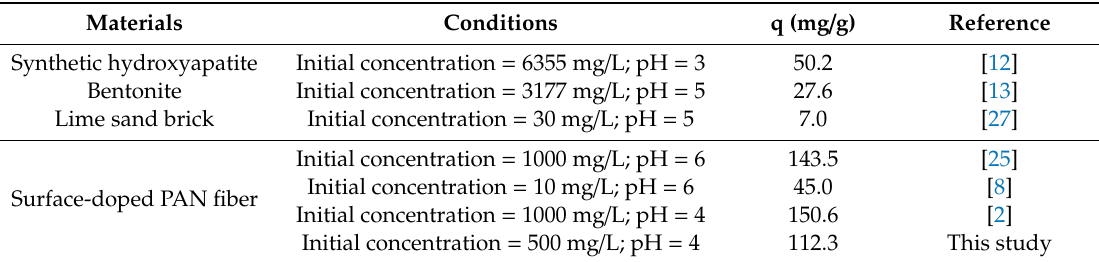
Table 3. Comparison of the adsorption capacity (q) of di ff erent fibrous ion exchangers and adsorbents for Cu(II) adsorption.